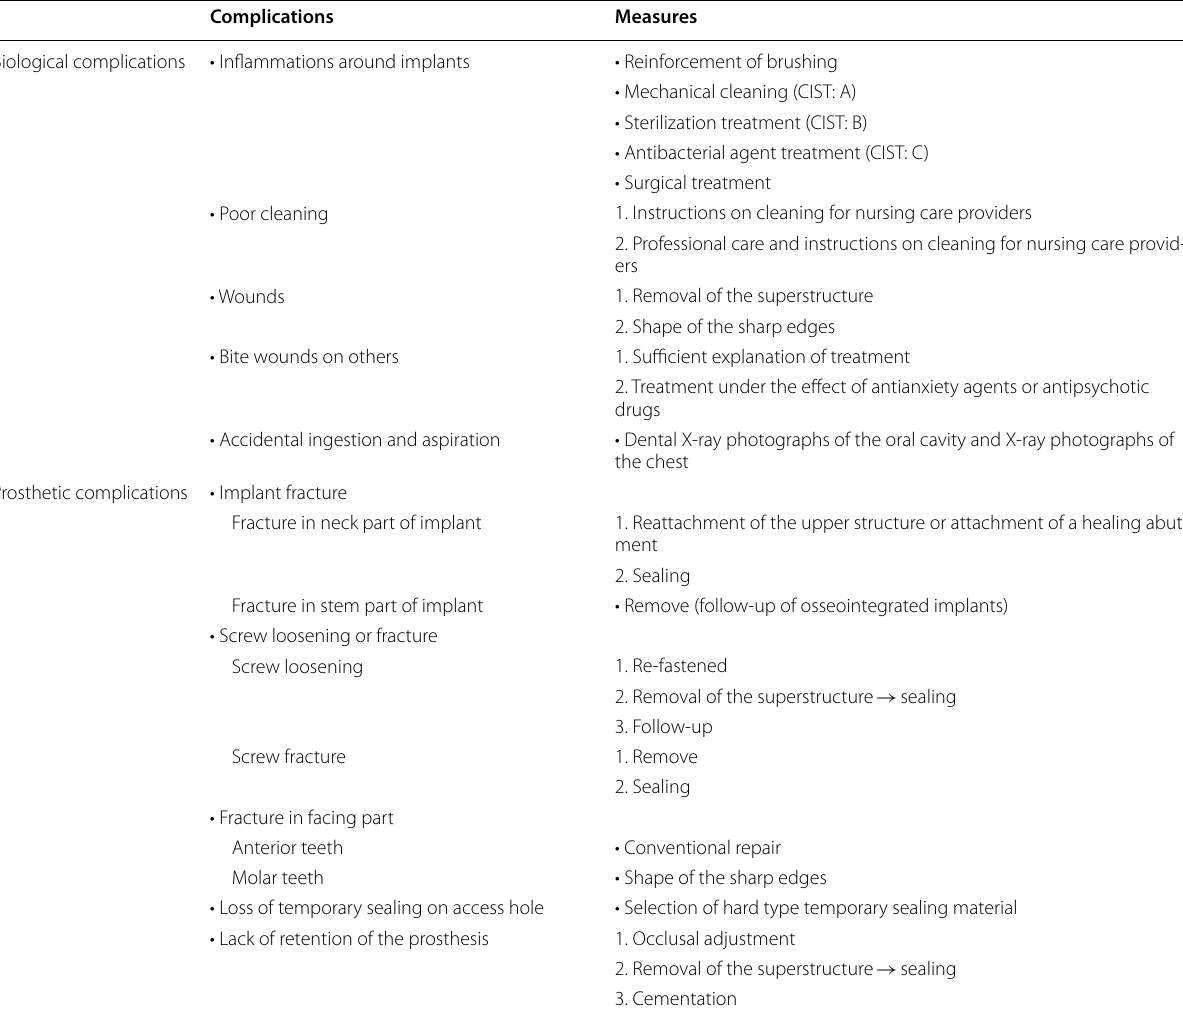
Table 1 Maintenance issues of elderly patients with implant treatments in dental